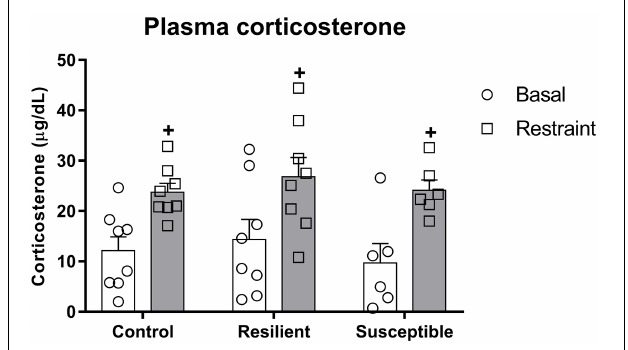
FIGURE 4 | Plasma corticosterone levels in susceptible and resilient rats to SDS in response to restraint stress exposure. Blood samples were collected 10 min before and right after 30 min of restraint stress. Bars represent means + SEM ( n = 6–8 animals per group). + p significant restraint stress